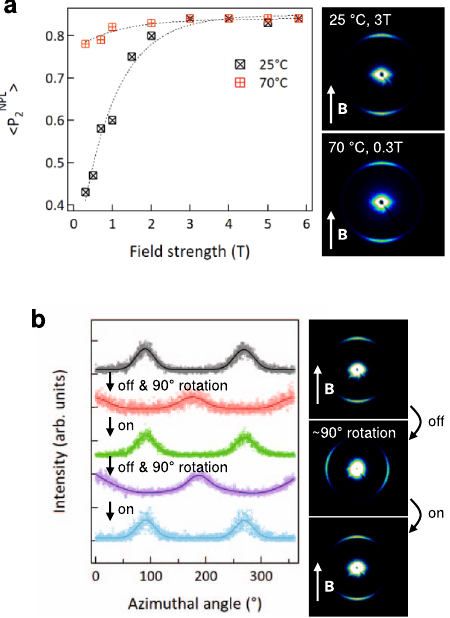
Fig. 3 Field strength dependence of NPL alignment and reversibly tunable NPL orientation by fi elds. a (left) Order parameter < P 2 NPL > of NPLs in PNBCB/6OCB as a function of fi eld strength at two different temperature conditions, 25 and 70 °C. (right) SAXS patterns obtained at 25 °C and 3 T and at 70 °C and 0.3 T, respectively. The direction of the magnetic fi eld ( B ) is indicated by the arrow. b (left) Change in an azimuthal intensity pro fi le of a NPL/PNBCB/6OCB composite upon fi eld on/off and sample rotation and (right) the corresponding SAXS patterns. Initially, the composite was aligned using a “ vertical ” fi eld at 25 °C and 3 T. It was then rotated ~90° in the absence of the fi eld (0 T) around the direction of X-ray incidence, such that the original magnetic fi eld direction, and the resulting LC director fi eld, were now “ horizontal ” . Upon applying the fi eld again in the vertical direction, the NPL orientation fully reverted within 10 s as the LC director fi eld realigned from horizontal to vertical. Additional experiment involving a 90° turn in the opposite direction demonstrates the reversible recon fi